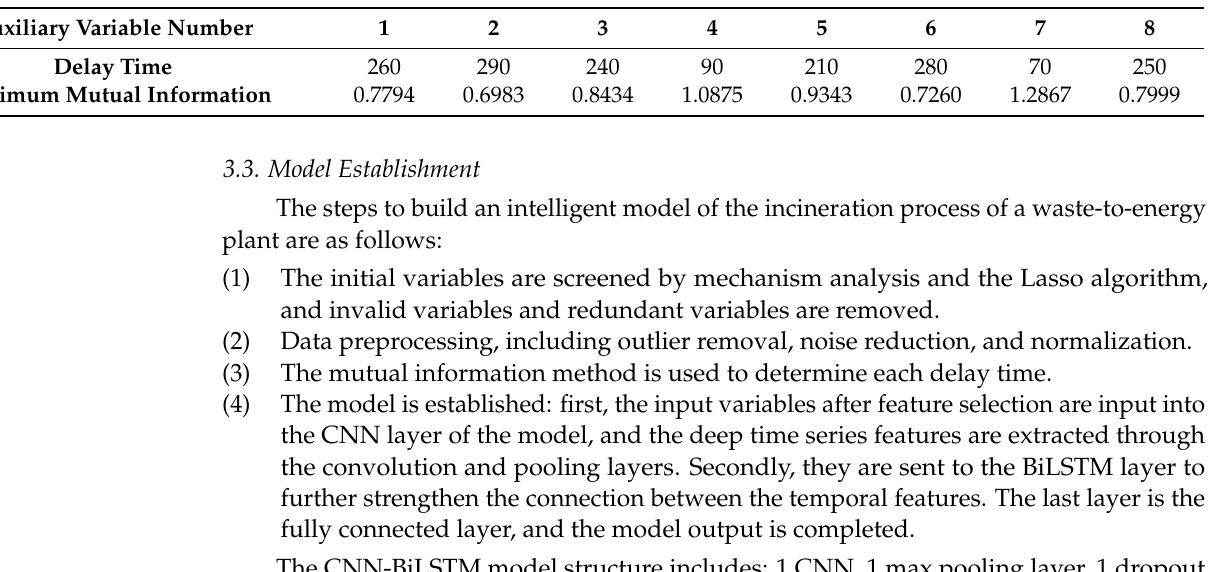
Table 2. Delay time and maximum mutual information of auxiliary